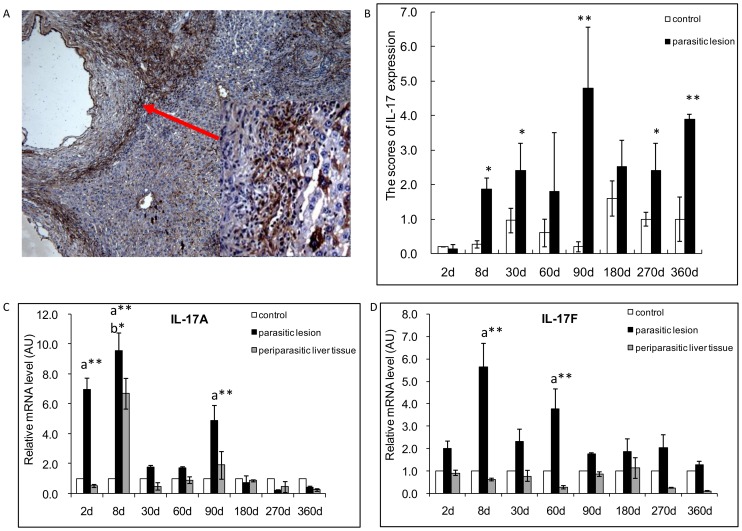
Th17-cytokine cytokine expression in the liver of mice during E. multilocularis infection.(A). Expression of IL-17 at day 90. IL-17 was present in most of the infiltrating lymphocytes of areas with inflammatory granulomas, in the cytoplasm of hepatocytes, endothelial cells of the hepatic sinusoids and fibroblasts (arrow indicates the area also shown at high magnification). (B). Expression scores of IL-17, calculated from quantitative analysis of the histo-immunostaining using both staining intensity and the percentage of cells stained at a specific range of intensities (see Materials and Methods section). (C). Course of IL-17A, and (D) of IL-17F gene expression in the liver of mice during E. multilocularis infection (measured by q RT-PCR). a: ‘Parasitic lesion’ versus ‘Control’; b: ‘Periparasitic liver tissue’versus ‘Control’. *P<0.05; **P<0.01. ‘Control’, non-infected mice; ‘Parasitic lesion’: E. multilocularis metacestode and surrounding immune infiltrate; ‘Periparasitic liver tissue: liver parenchyma close to the E. multilocularis lesion, but excluding macroscopically visible liver tissue alterations. AU: arbitrary units.